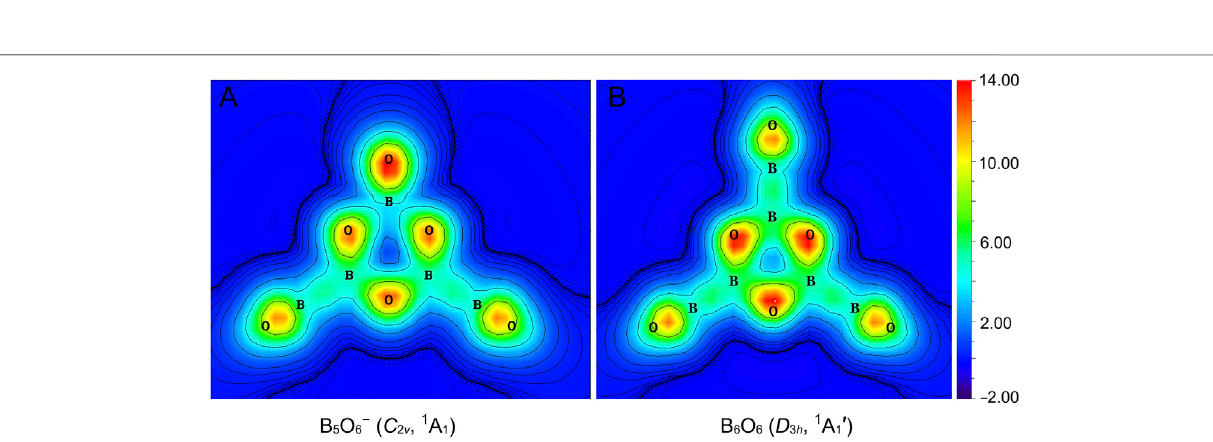
FIGURE 9 | Color- fi lled maps of iso-chemical shielding surfaces (ICSSs) in the z-direction, ICSS zz (in ppm), for (A) B 5 O 6 − (1) and (B) boronyl boroxine D 3 h B 6 O 6 clusters. Positive ICSS zz values indicate aromaticity. The calculations are carried out on a plane that is 1.0 Å above the molecular plane.